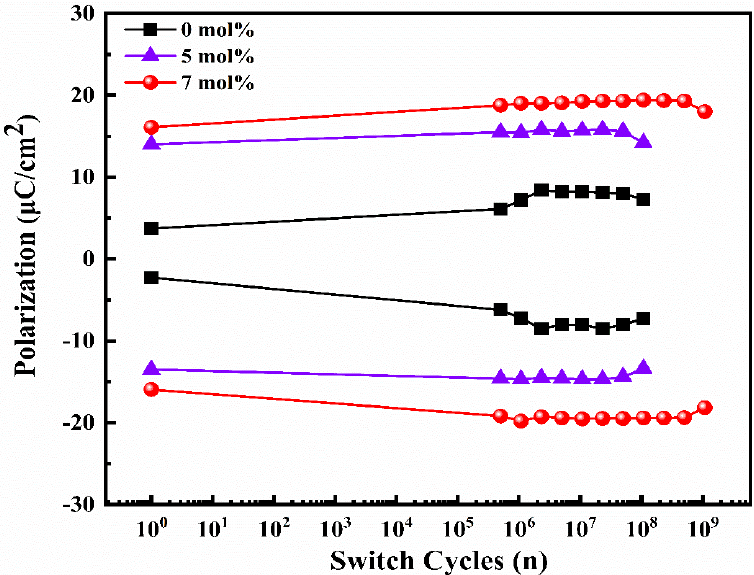
Figure 7. Endurance properties of thin films (0, 5, 7 mol%) at a cycling field of 2.5 MV/cm and a frequency of 500 kHz. Table 1. Properties of HfO 2 -based ferroelectric thin films fabricated by